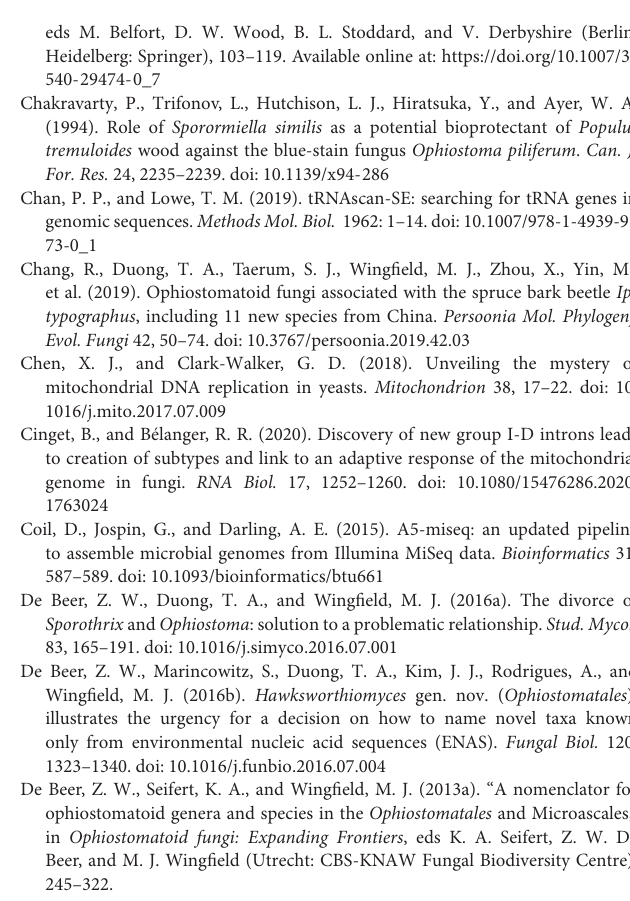
Supplementary Table 1 | Comparison of the mitochondrial genomes and their intron complement for the studied members of the Ophiostomatales. Supplementary Table 2 | Intron subtypes and intron open reading frames (ORF) recorded noted within the mitogenomes of the examined members of the Ophiostomatales. Supplementary Data File 1 | Mitogenome assemblies and